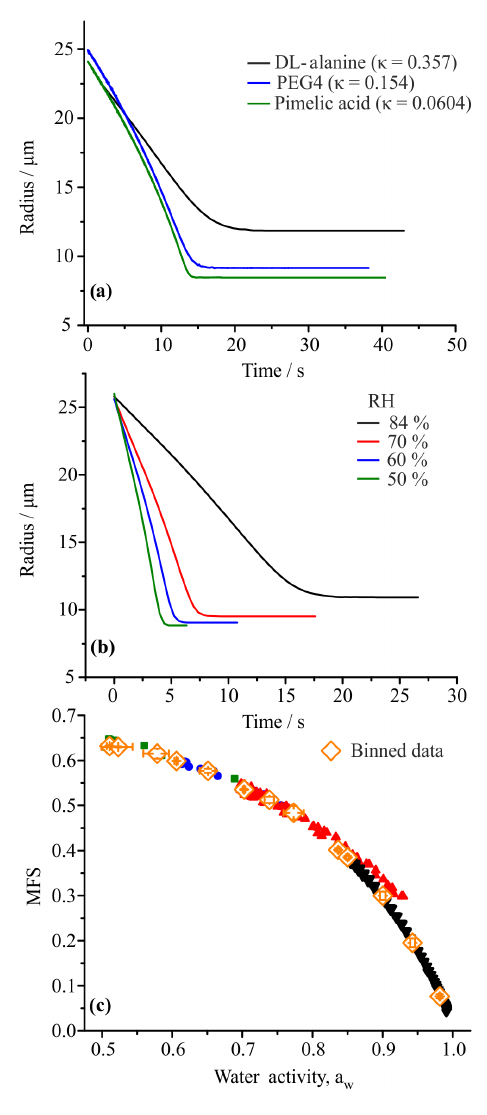
Figure 1. (a) Examples of the time-dependent evaporation of aque- ous droplets containing compounds with varying κ values evapo- rating into similar RHs ( ∼ 82%). (b) The time dependence of the radii of droplets of aqueous glycine evaporating into different RHs. (c) Equilibrium hygroscopicity curve for glycine, with binned data points (large, open, orange diamonds) estimated across the four dif- ferent experiments at four RHs shown in (b)